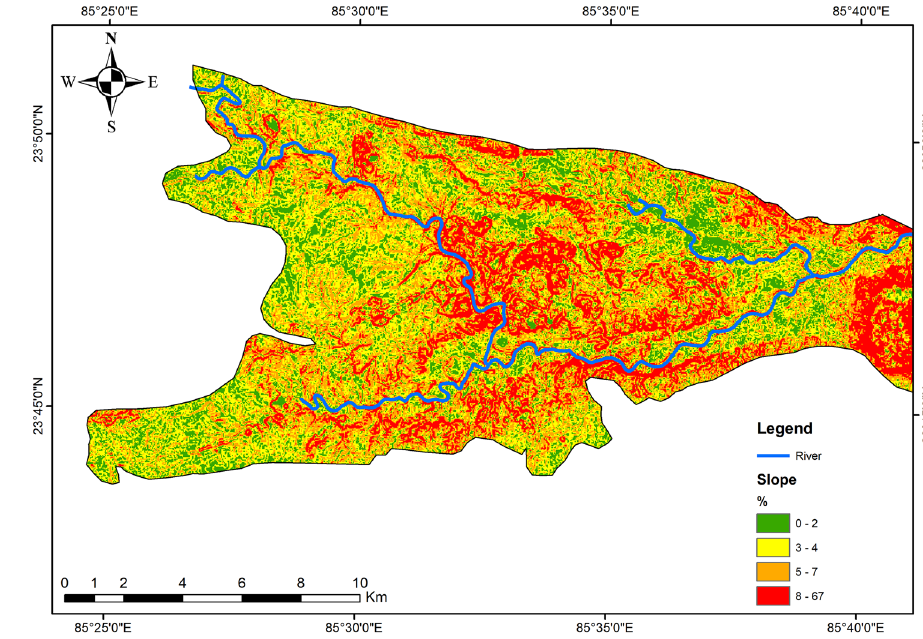
Fig. 3 Slope class map of